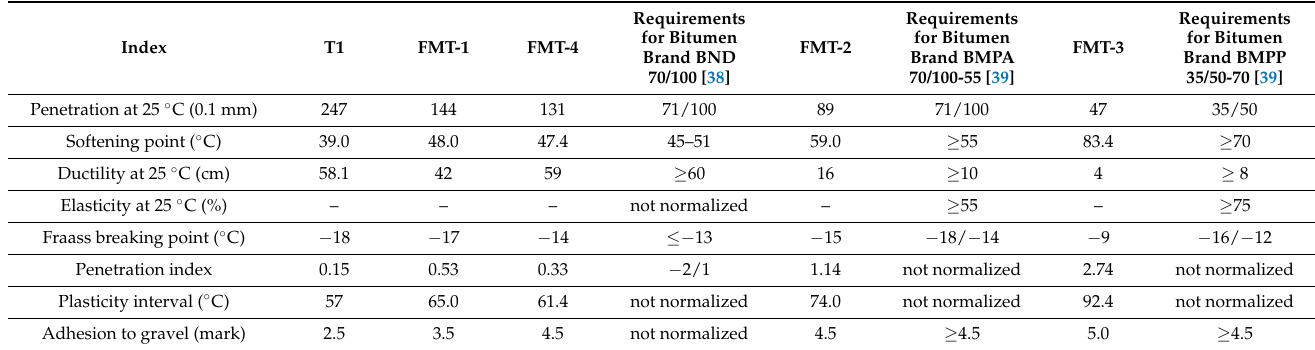
Table 4. Physical and mechanical properties of FMTs.